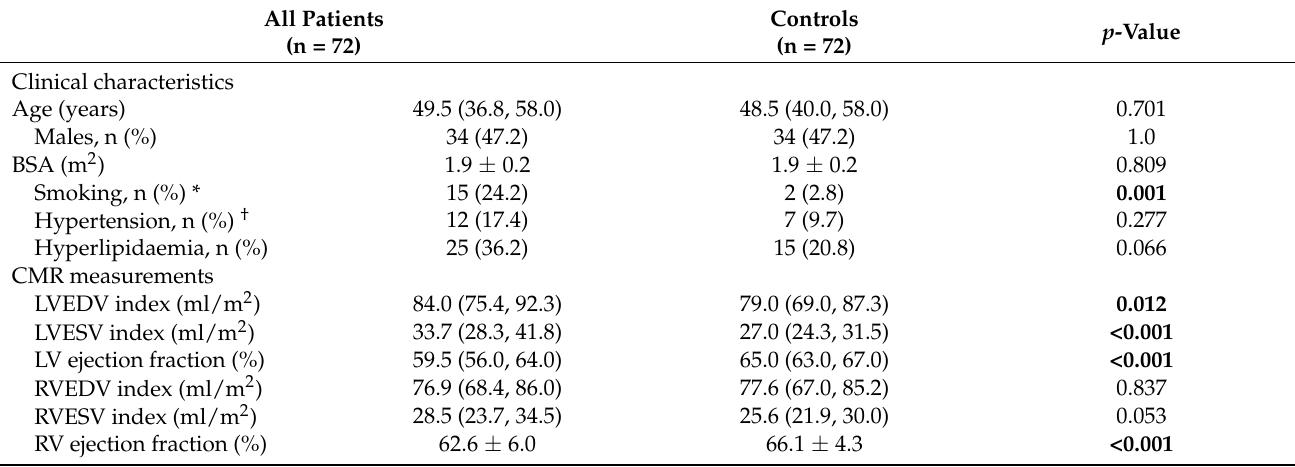
Table 1. Baseline clinical characteristics and CMR measurements of patients and matched control subjects. All